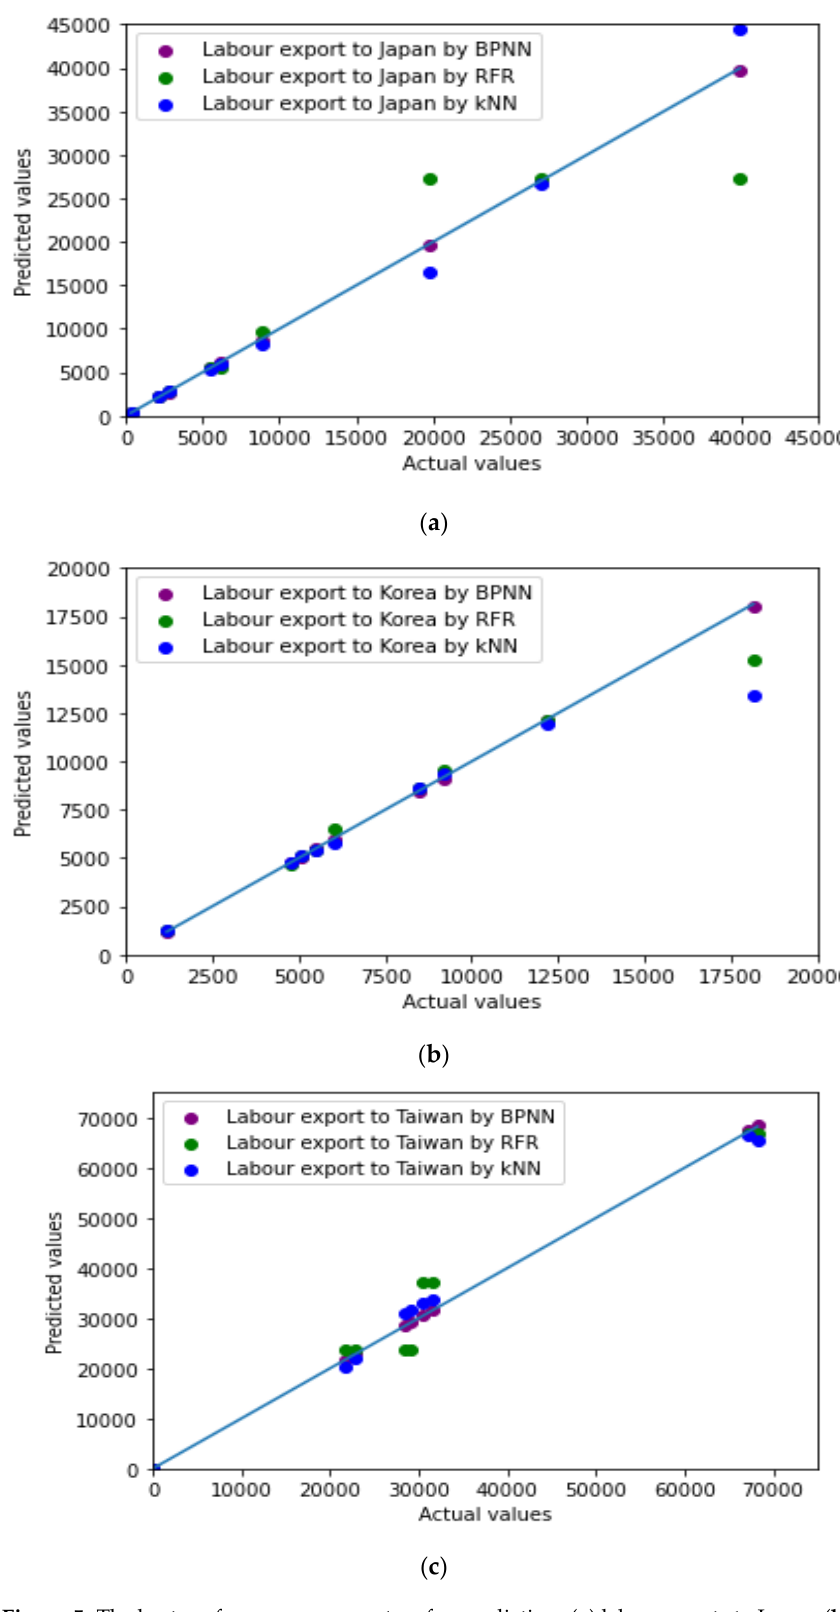
Figure 5. The best performance parameters for prediction: ( a ) labor exports to Japan, ( b ) labor exports to Korea, ( c ) labor exports to Taiwan (unit: people).